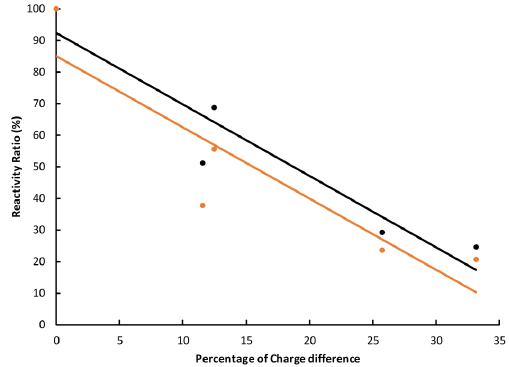
Figure 5. Structure-cross-reactivity relationship of the rabbit (black) and mice (orange) antibodies.